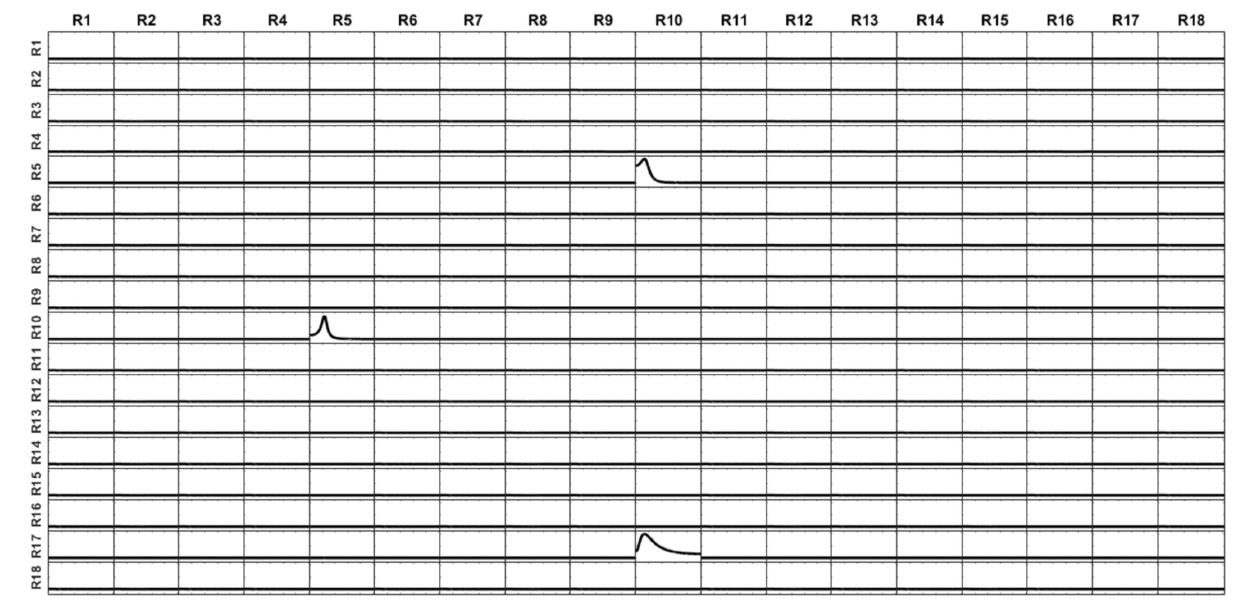
FIGURE 12 | iCoh perfect reconstruction of the connectivity patterns simulated for the 18 surface regions, after application of the unmixing procedure for these surface regions, as described in section Unmixing through regions on the cortex surface with known source